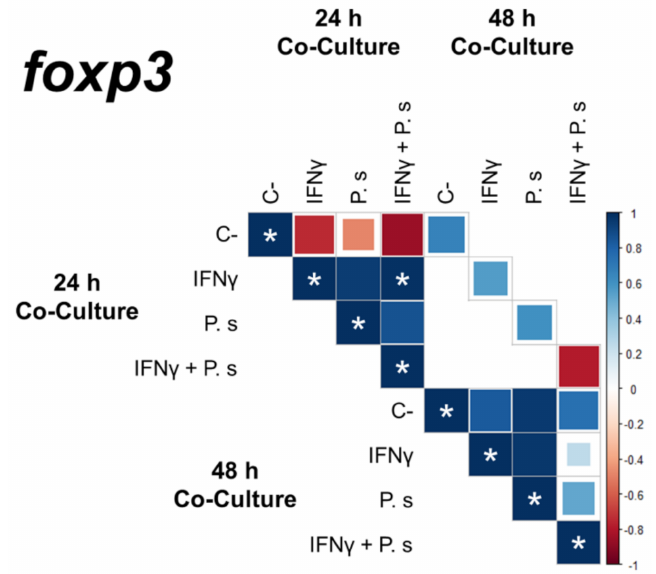
Figure 6. Correlation coefficient of foxp3 gene expression in co-cultures of CD4 + IgM − cells and adherent splenocytes (MHCII + CD83 + /MHCII − CD83 − ) cells at 24 and 48 h. C—-control without induction. IFN γ —splenocytes cells induced with IFN γ . P.s—splenocytes induced with P. salmonis . IFN γ + P.s—splenocytes induced with IFN γ and P. salmonis . * significant value ( p <